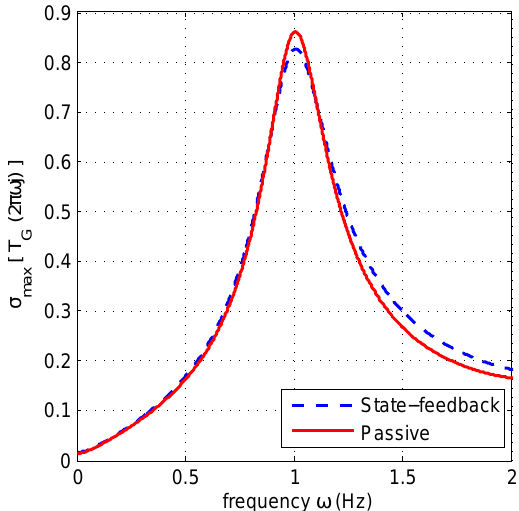
Figure 8: Maximum singular values for T G ( jω ) corresponding to the state-feedback controller. The ex- cellent behavior of the passive damping system can be clearly appreciated in the graphics of maximum singu- lar values of the pulse transfer functions T G ( jω ) (blue s dashed line) and T G ( jω ) (red solid line) displayed in d Figure 8.